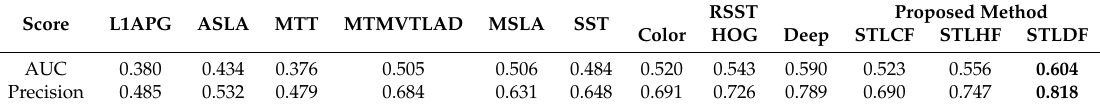
Table 1. Summary of the tracking performance of the proposed tracker, its two variants, and nine representative sparse trackers on OTB50. Bold numbers indicate the highest area under curve (AUC) and precision scores (i.e., the best tracking